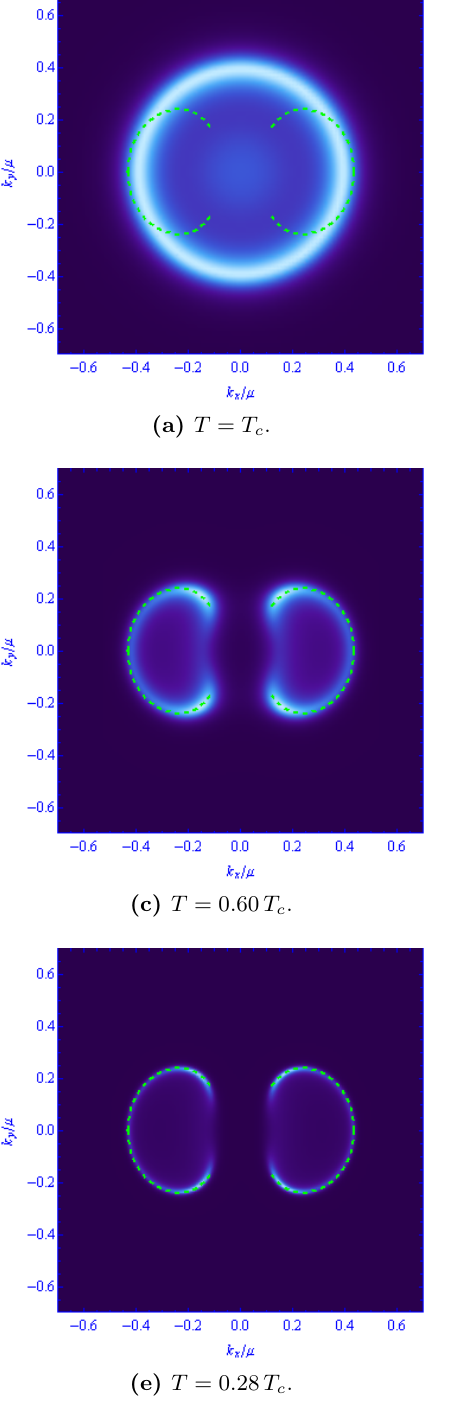
Figure 10. The spectral function for di(cid:11)erent temperatures and (cid:12)xed (cid:21) = 0 : 62 = (cid:21) c , ! = 0 : 12 (cid:22) . It is observed the presence of spherical symmetry at T = T c . The dashed lines indicates the locus of the normal modes. The purple and red circles represent the UV and IR Dirac cones respectively.